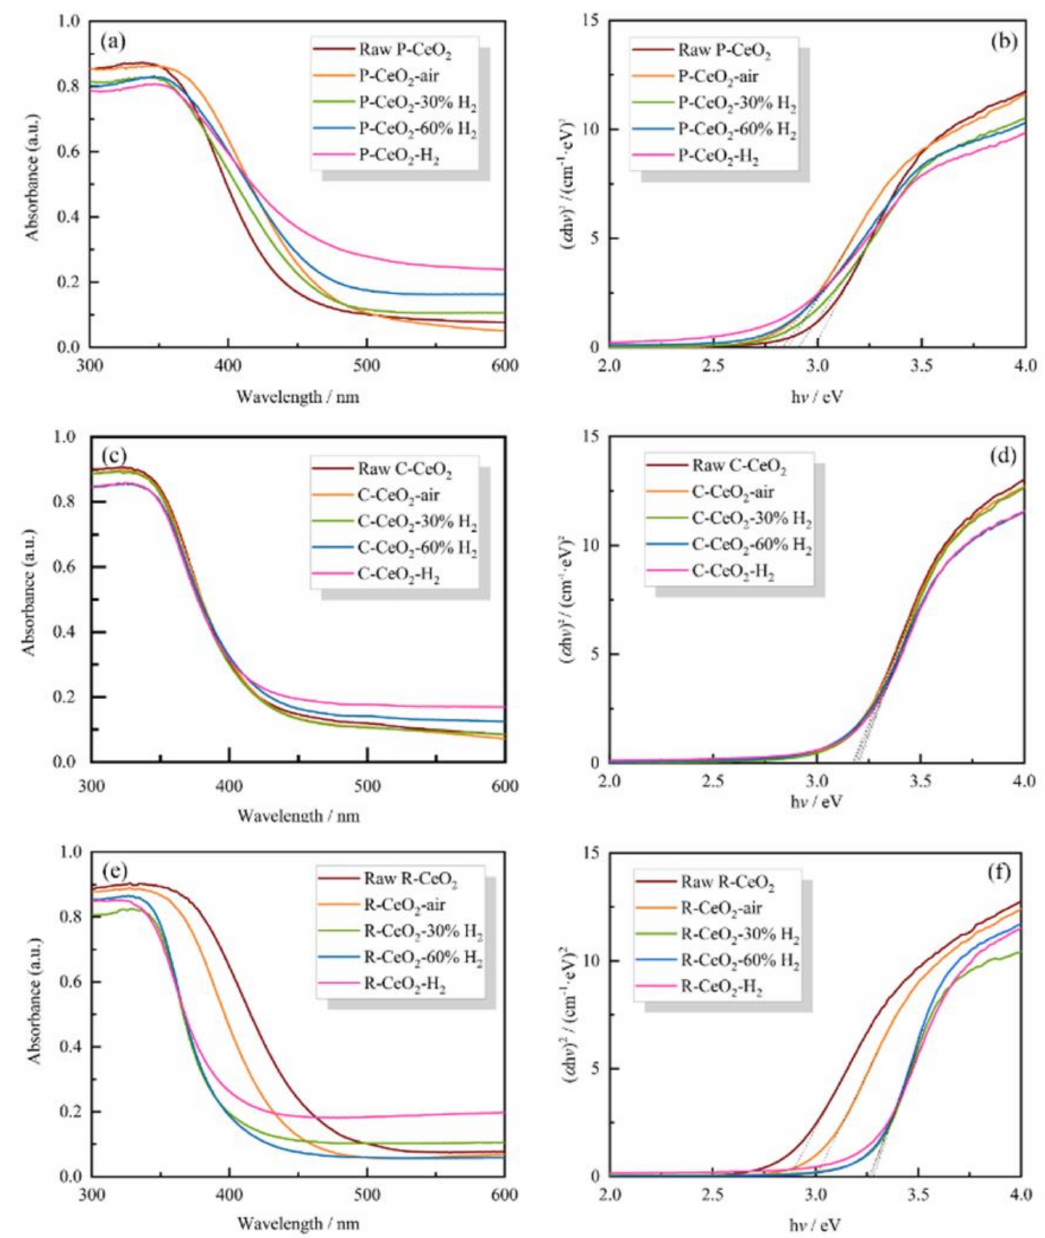
Figure 6. UV-Vis DRS and energy band curves of P-CeO 2 ( a , b ), C-CeO 2 ( c , d ) and R-CeO 2 ( e , f ) calcining in different concentration of H 2